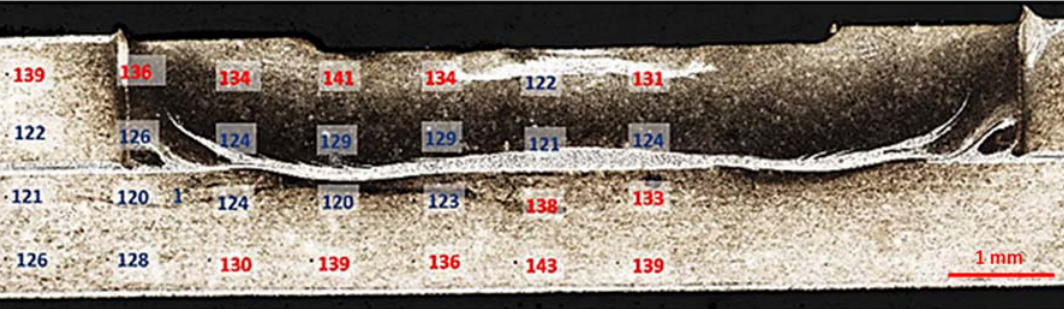
Figure 11. Static strength test results for RSW joints . 4.30